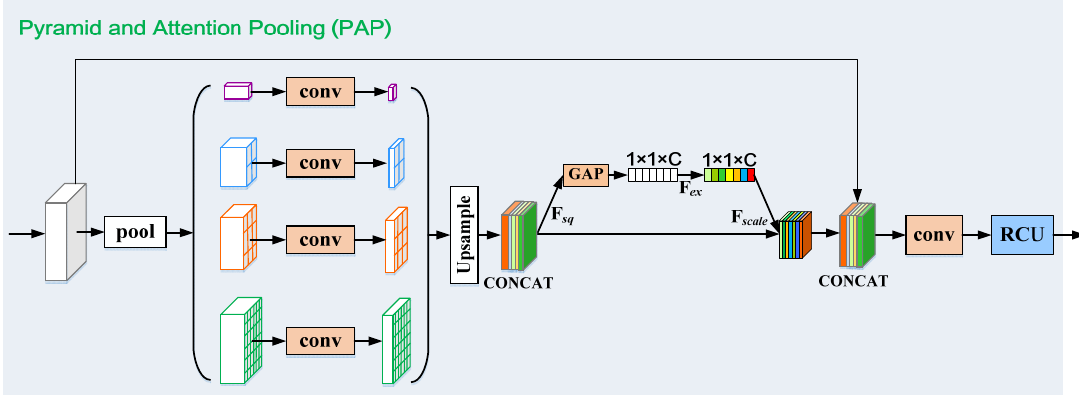
Figure 4. The pyramid and attention pooling.